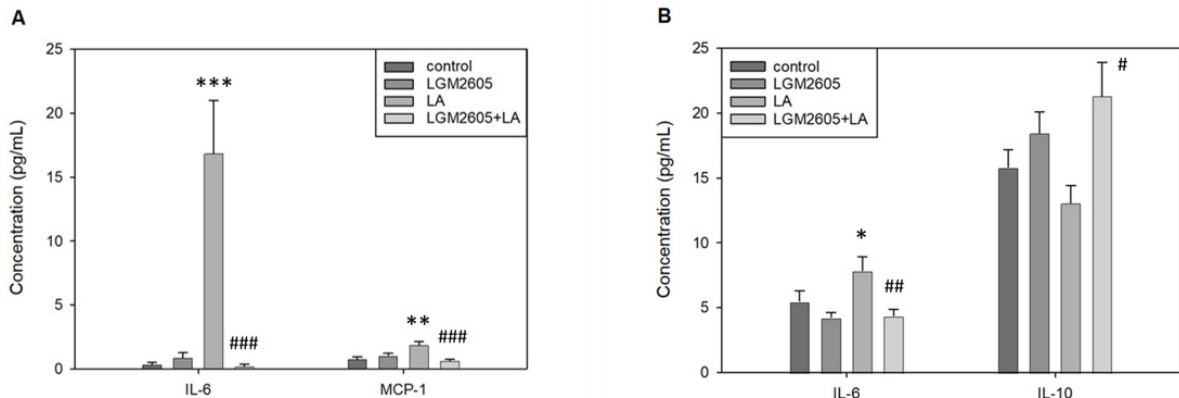
Figure 8. Detection of cytokines in PLF and sera by cytometric bead array. ( A ) In PLF, LA treatment significantly increased